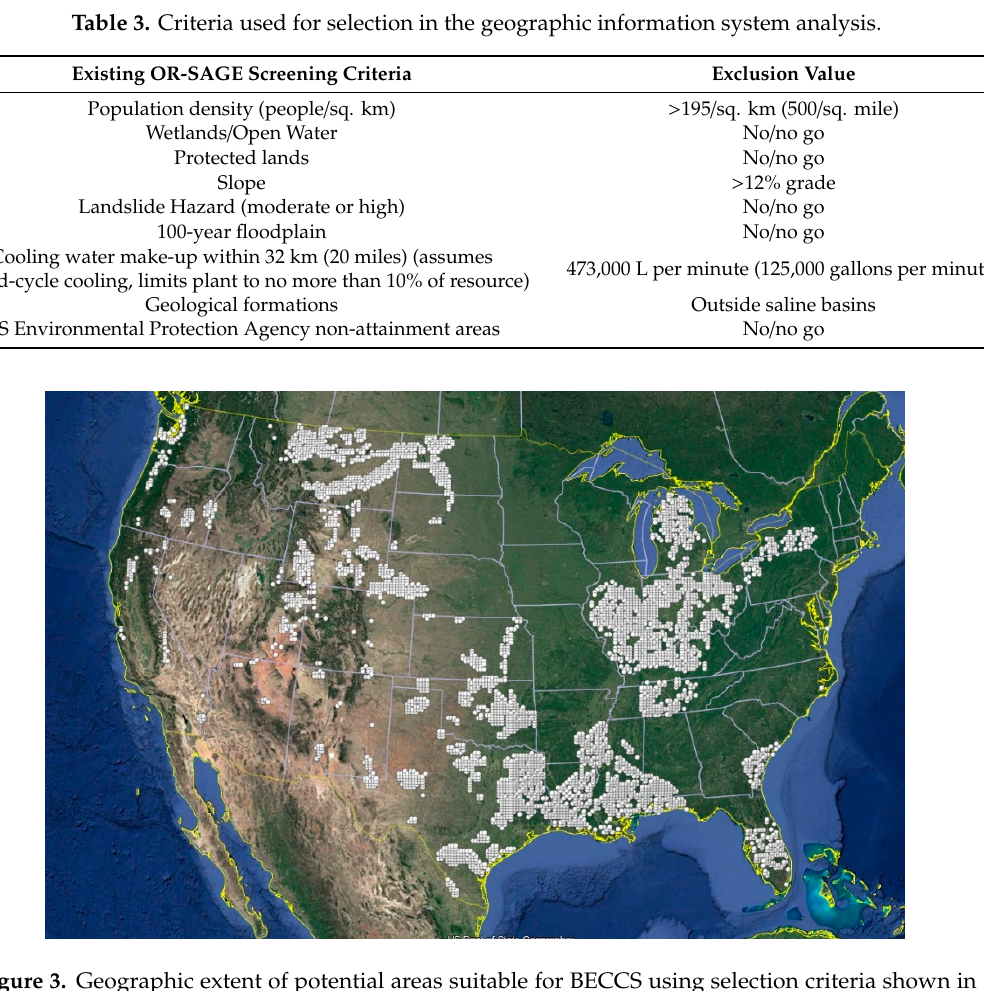
Table 3 . Potential facility locations within these suitable areas are shown in Figure 4. Table 3. Potential facility locations within these suitable areas are shown in Figure